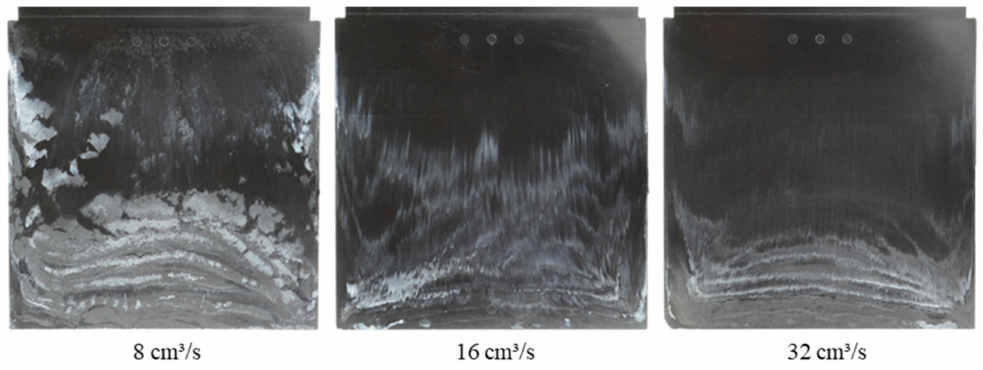
Figure 7. PF1110 (GF35+GB45); influence of injection speeds on the slip phenomenon.